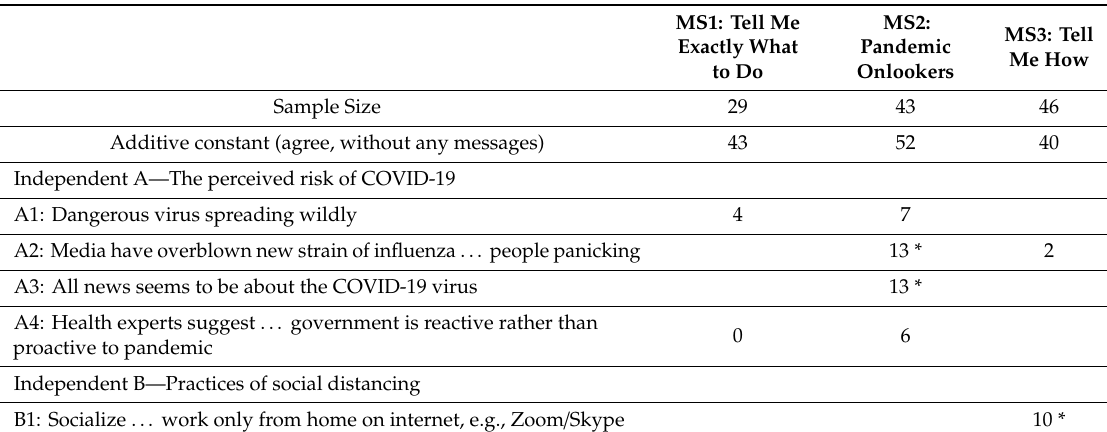
Table 4. Three mindset segments (MS) for the United States of